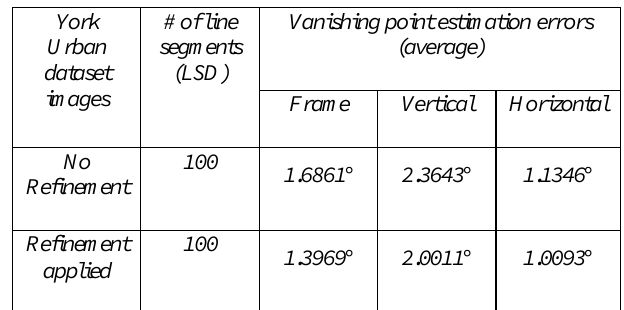
Table 2. Vanishing point estimation on York Urban